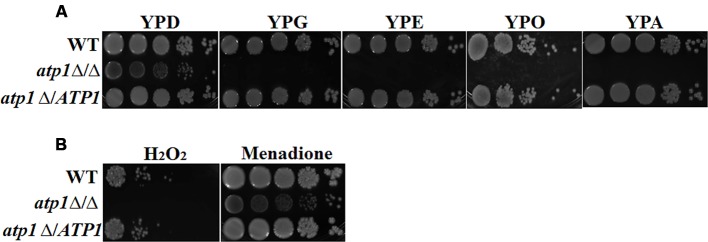
Deletion of ATP1 disables utilization of non-glucose carbon sources and elevates oxidative stress. (A)
C. albicans strains were grown overnight in YPD medium, washed and serially diluted in PBS. Three microlitres of each serial dilution was plated on the YP medium supplemented with 2% glucose (YPD), 2% glycerol (YPG), 3% oleic acid (YPO), 2% ethanol (YPE), or 2% acetate (YPA) agar plates. (B) Oxidative stress response. Strains were grown in the presence of 8 mM hydrogen peroxide and 0.05 mM menadione. All cultures were incubated for 2 days at 30°C.